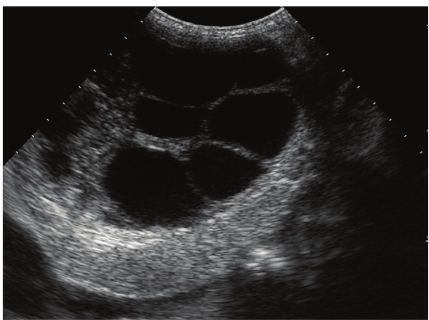
Figure 1: Ultrasonography scan of liver showing multilocular anechoic cystic lesion made up of multiple cysts that ranged from 10 to 45mm in diameter occupying whole left hepatic lobe. Biliary and vascular structures are displaced but not involved.